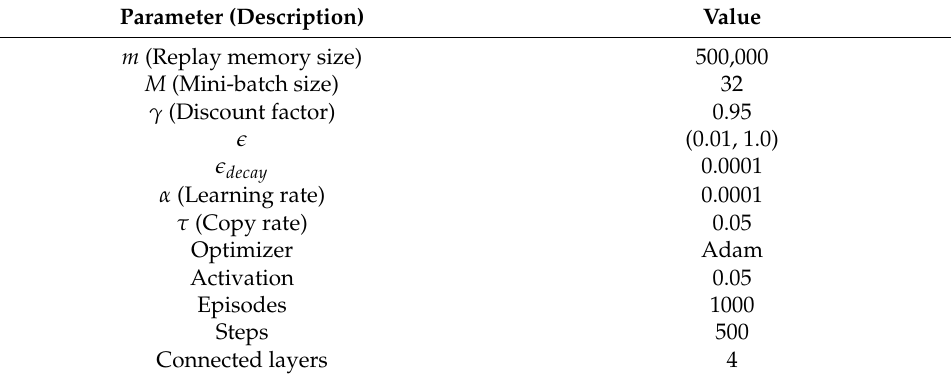
Table 2. The parameters used for